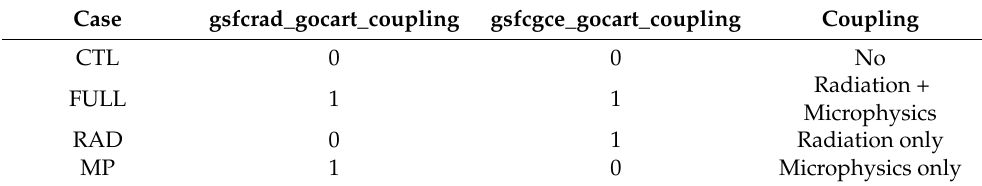
Table 2. Coupling strategy: namelist variables for the different simulation